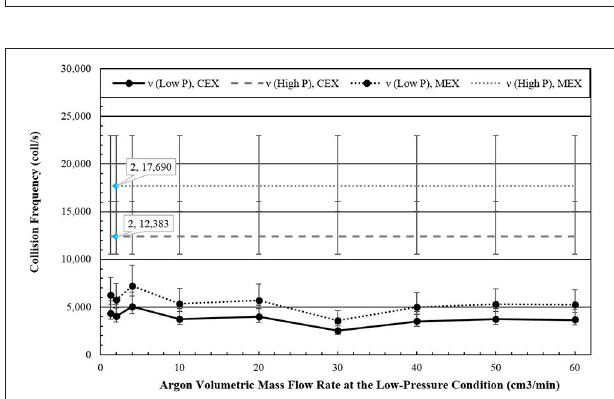
FIGURE 8 | Charge-exchange (CEX) and momentum-exchange (MEX) collision frequencies at the “Low-Pressure” (Low P) and 2 cm 3 /min flow rate “High-Pressure” (High P)